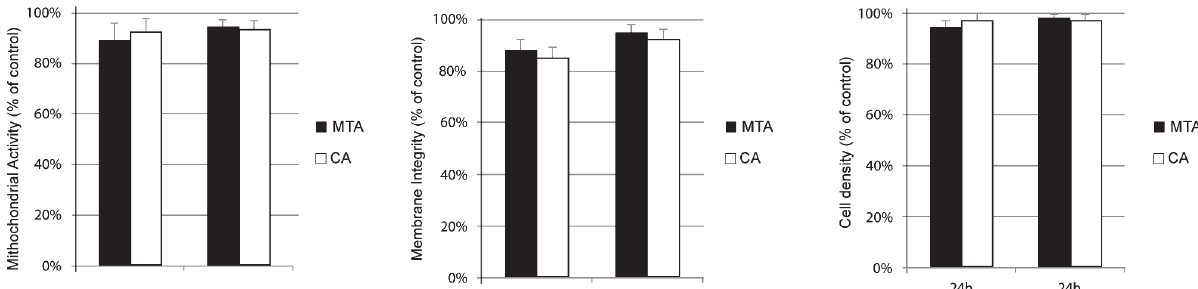
Figure 2- Cytotoxic effects of materials elutes on 3T3 cells by XTT, NR, and crystal violet tests, expressed as percentage of control (cells exposed to culture medium). Bars indicate mean±SD SD=Standard Deviation; NR=neutral Table 1- Mean and standard deviation of the zones of microbial growth inhibition (mm) provided by the materials as well as statistical significance*